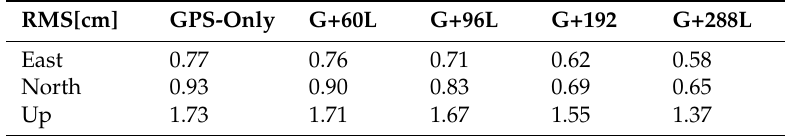
Table 5. Statistics of the baseline solution precisions after fixing ambiguity in three directions.